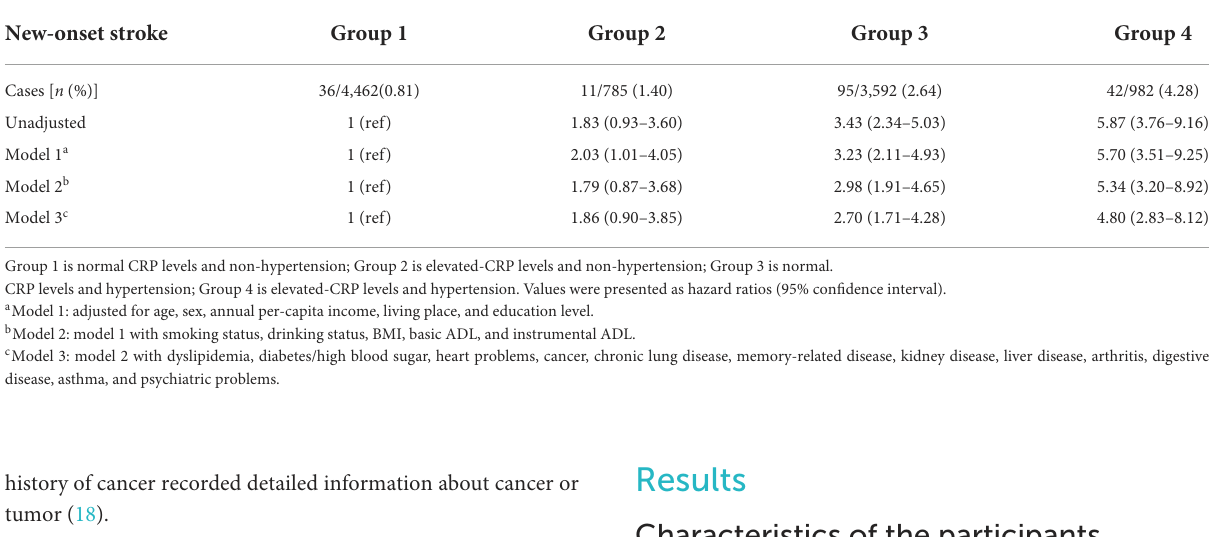
TABLE 2 The joint association of elevated-CRP levels and hypertension with new-onset stroke in